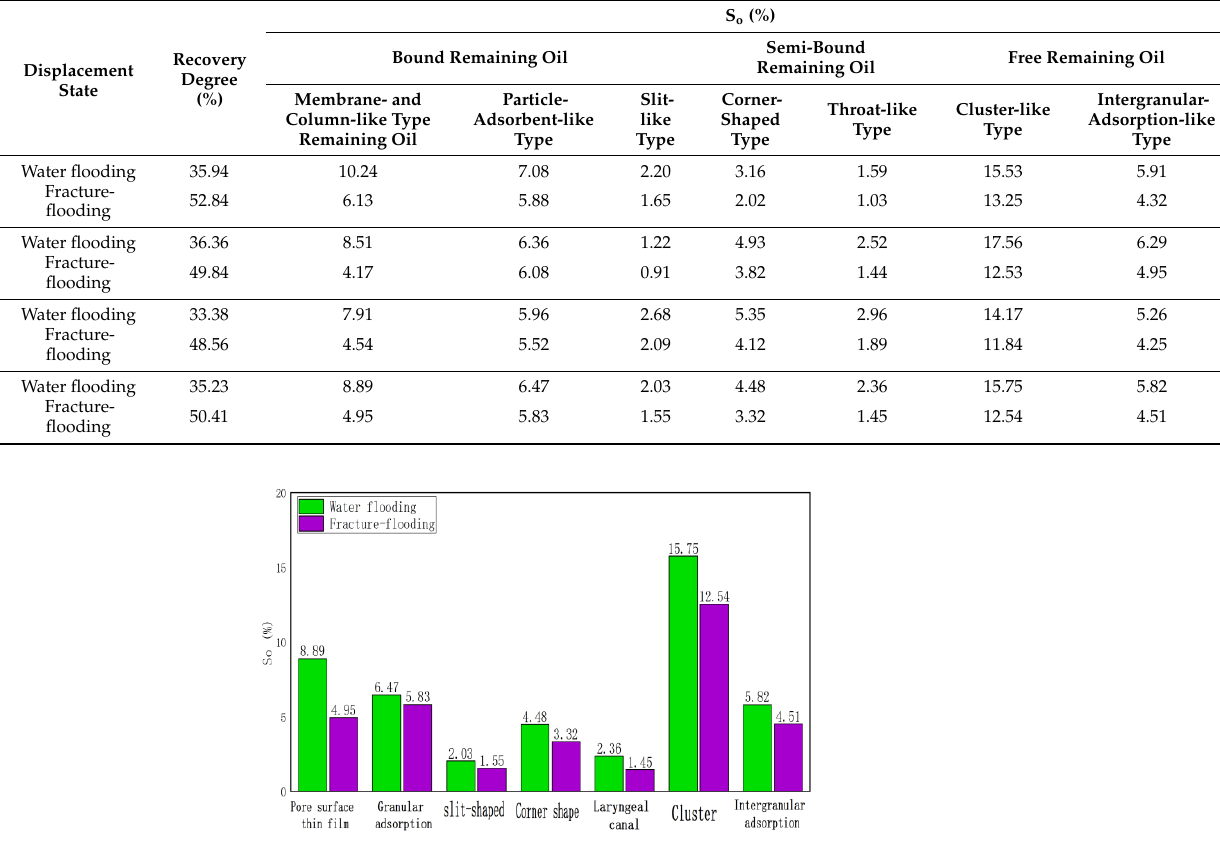
Table 4. Relative percentage of remaining oil distribution.